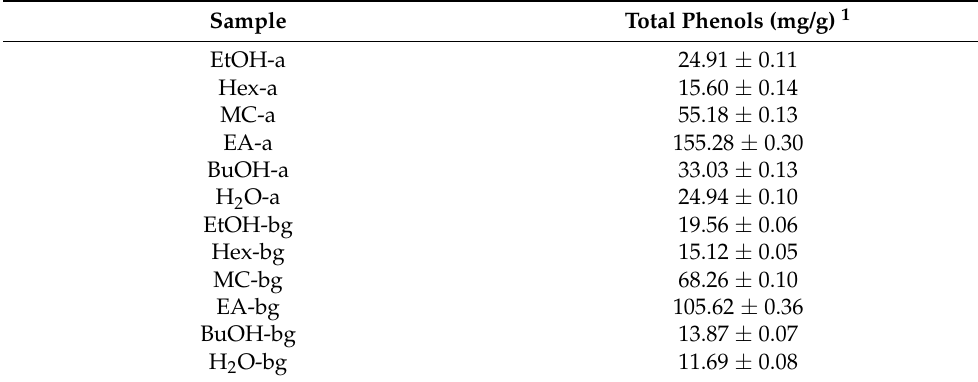
Table 2. Measurement of total phenol contents of the extracts and fractions of Spartina anglica